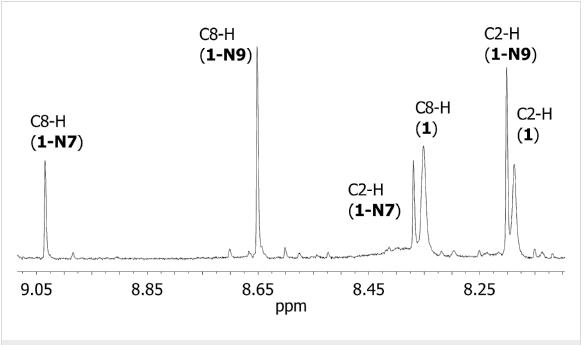
Figure 1: 1 H NMR spectrum (downfield region) of the reaction mixture (adenine anion 1 and FcCOCl) in DMF, taken after 10 minutes (see numbering in Scheme 1) at 25 °C. The DMF signal was suppressed by the presaturation option, and DMSO- d 6 was used as a deuterated sol- vent in